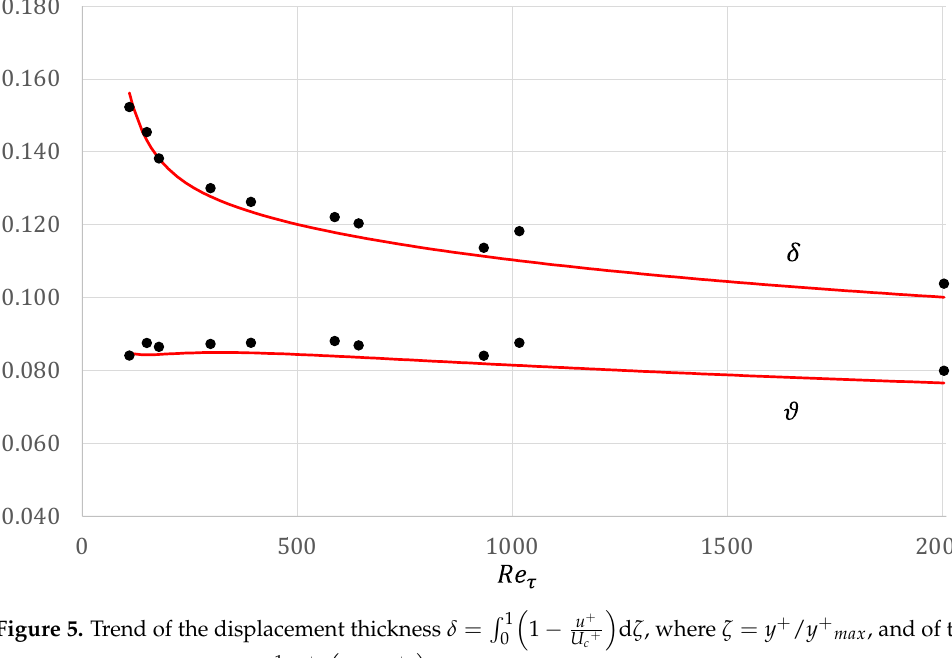
Figure 4. Trend of the skin friction based on the mean velocity C f friction based on the centerline velocity C f